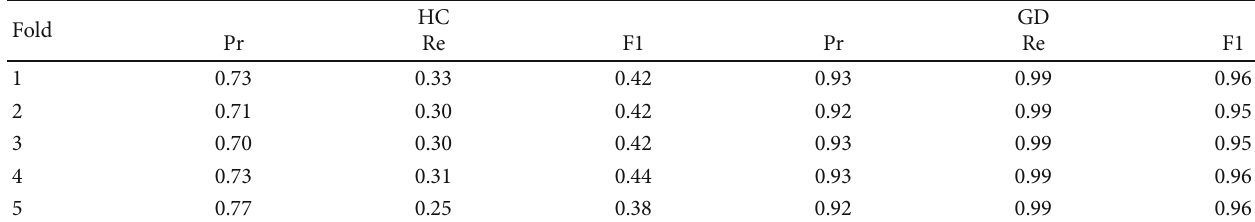
Table 7: Fivefold cross-validation result on the GaitRec dataset.